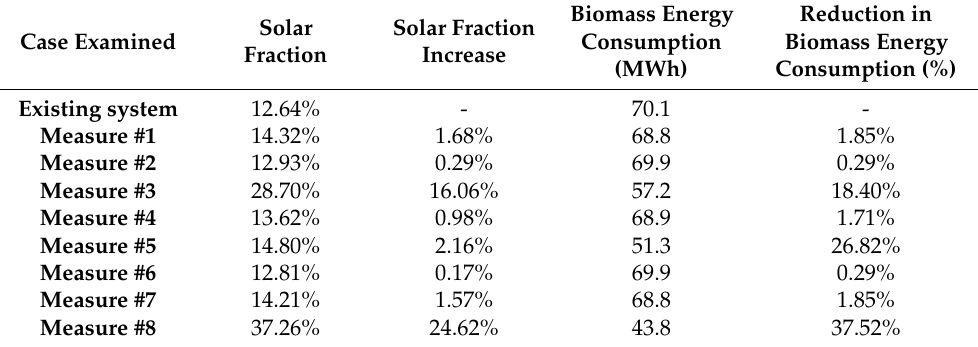
Table 11. Solar fraction (f) and biomass energy consumption values for each case under